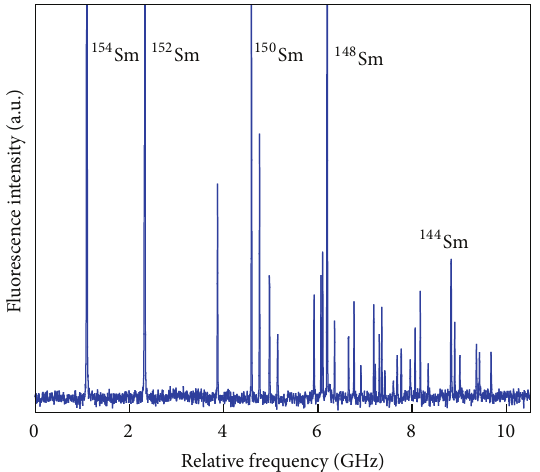
Figure 2: Observed fluorescence spectrum of the 4 f 6 6 s 2 7 𝐹 2 – 4 f 6 6 s 6 p 9 𝐷 3 transition at 680.30 nm in Sm I. Peaks of the even- mass isotopes are labeled with their atomic symbol. Other peaks are hyperfine structure peaks of the two odd-mass isotopes 147 Sm and 149 Sm.